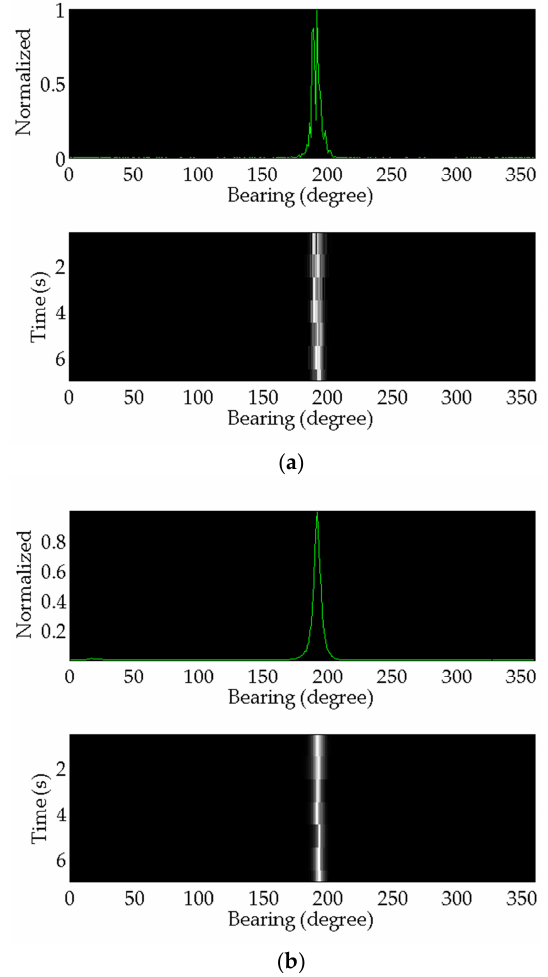
Figure 13. The azimuth angle estimation results of the target transponder ship. ( a ) The result of the conventional method; ( b ) Th result of the proposed method.